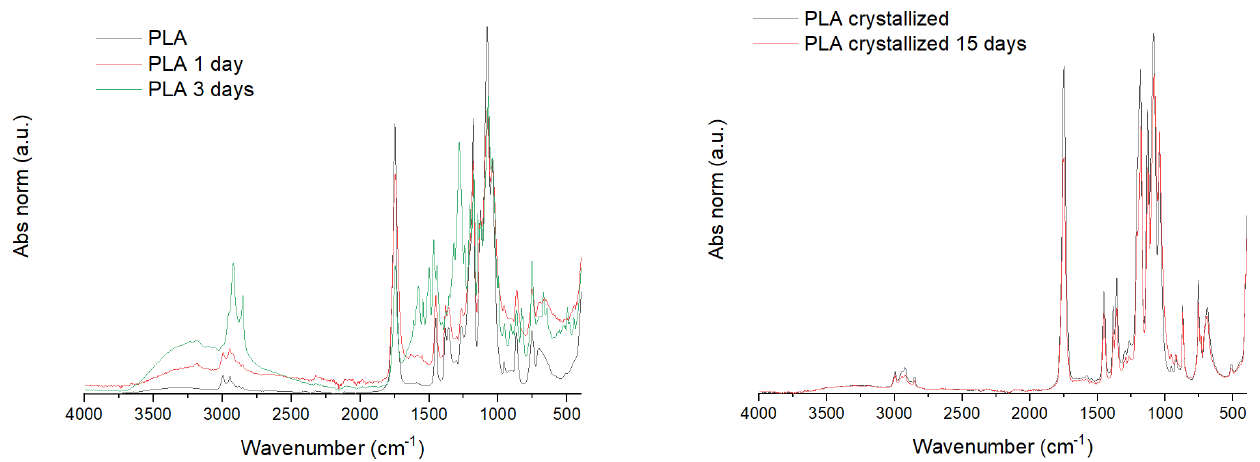
Figure 4. FT-IR of PLA amorphous and crystallized samples and some degraded specimens.